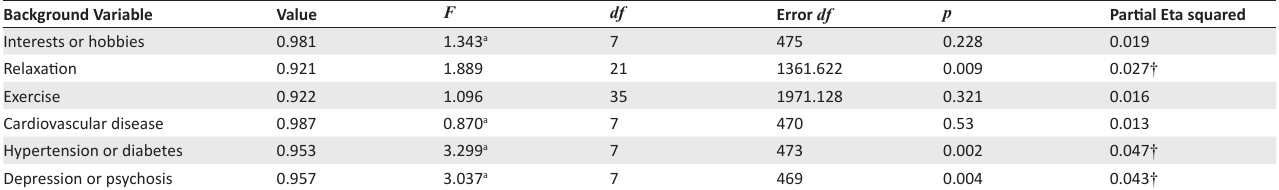
TABLE 5: MANOVAs – Wilks’ Lambda lifestyle variables and the EnergyScapes Profile dimensions. Background